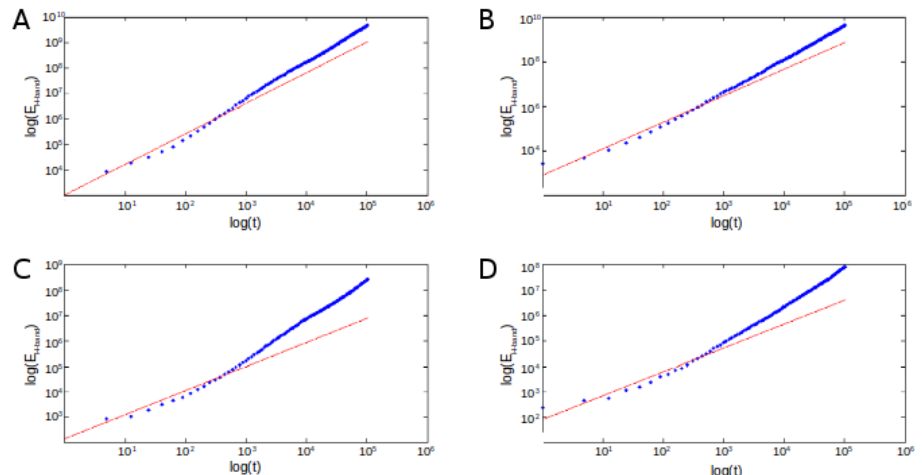
Figure 11. Linear fit to inter-molecular H-bond energies for HA according to sample MSD method. Two pictures in left column correspond to c 1 concentration and pictures in right column correspond to c 4 concentration. Two pictures in first row correspond to normal physiological structure. In the second row - pathological